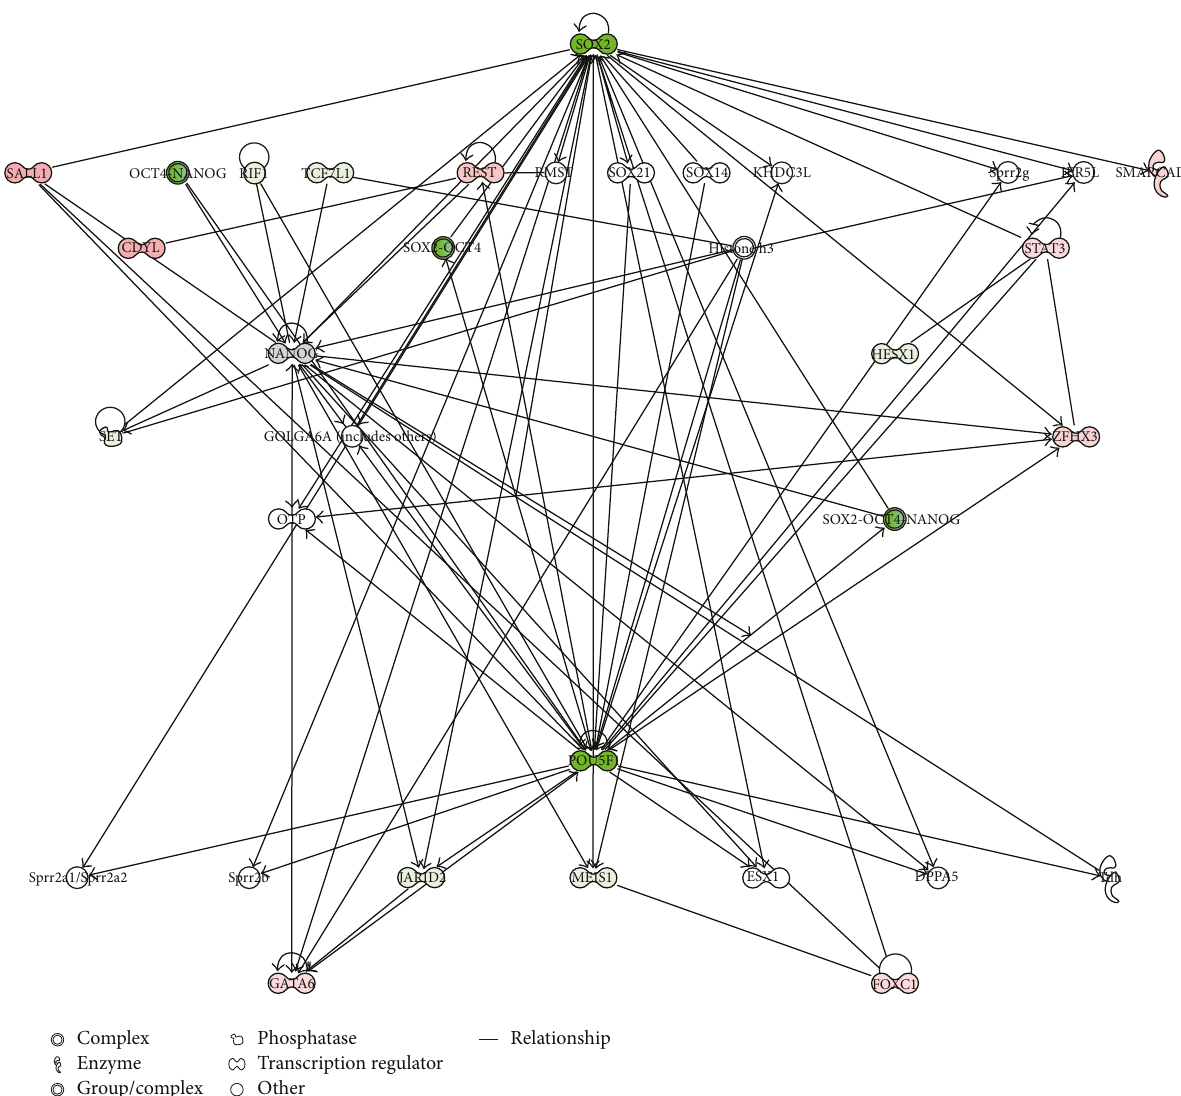
Figure 9: Gene modulation of hGMSCs. IPA-inferred cluster analysis of the hGMSC dataset of signi fi cantly expressed genes at